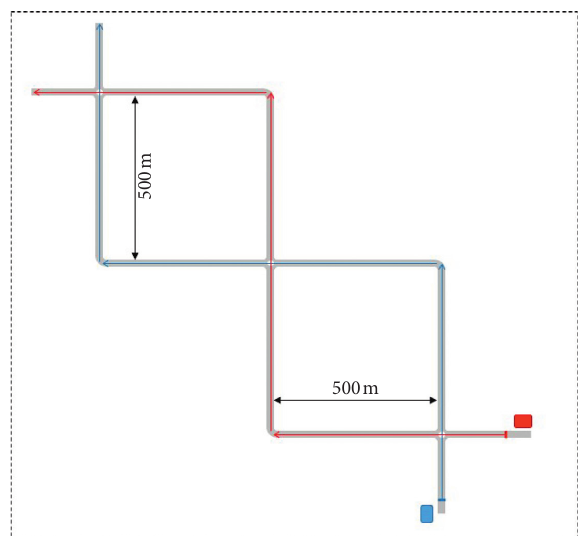
Figure 2: Foundation road network and the route of each